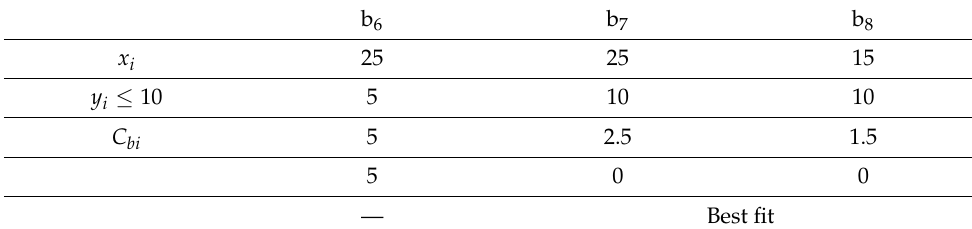
Table 11. Branch and bound for b i at Y avi < 10.